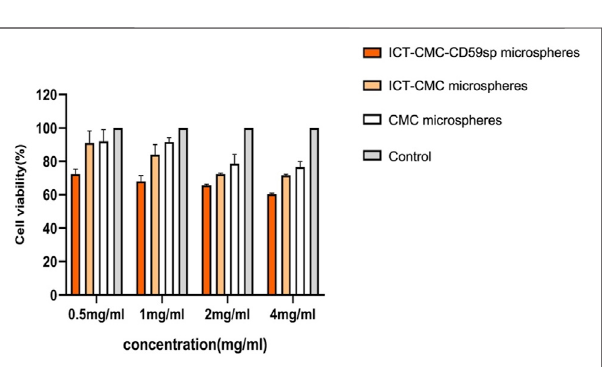
FIGURE 6 | Effect of ICT-CMC-CD59sp on keratinocytes.